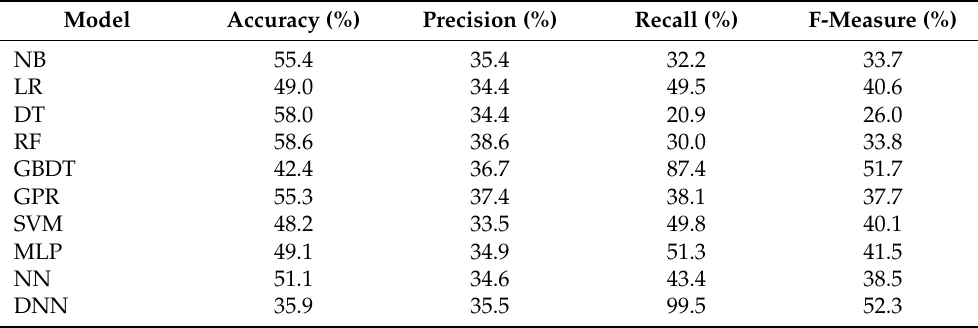
Table 13. Comparison of results of machine learning models for analysis based on outdoor air temperature.